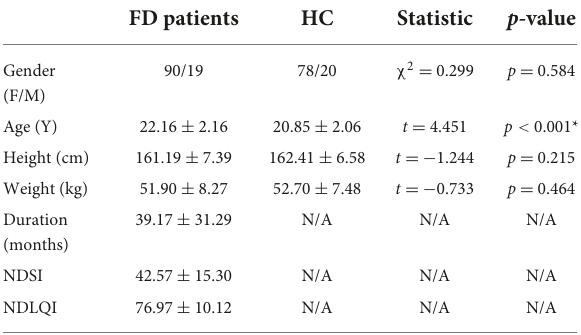
TABLE 1 The demographic and clinical characteristics of the eligible FD patients and HC.